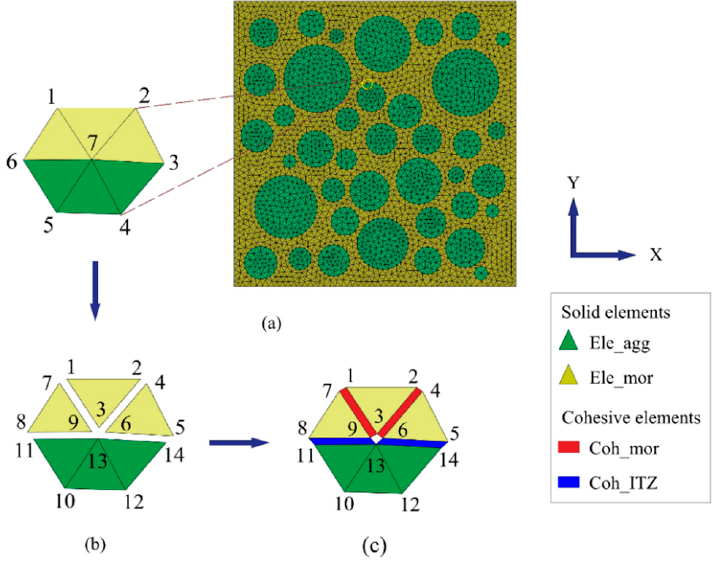
Figure 3. The key process of the CIEs insertion. ( a ) Read the node and element information of the initial mesh topology; ( b ) Copy and re-number the nodes; ( c ) Generate the CIEs. Note: The numbers represent the node numbers.